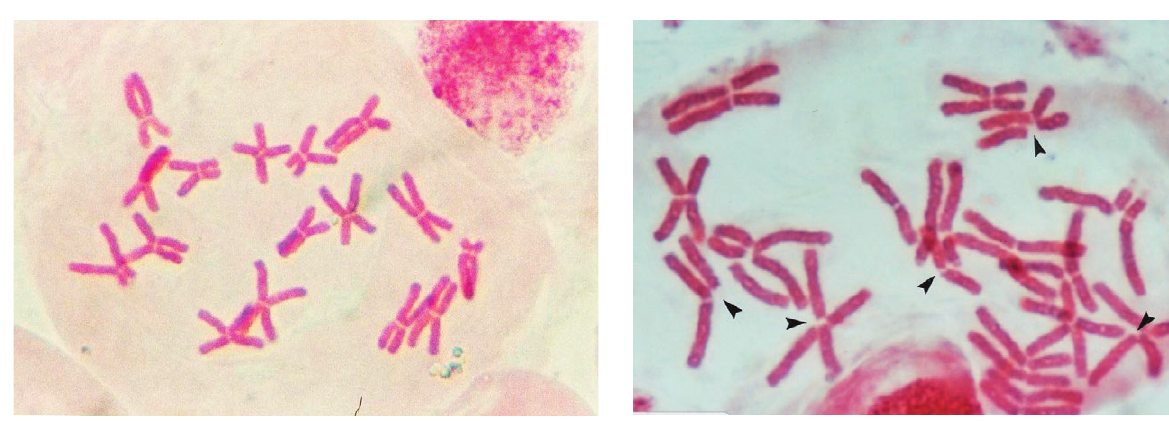
Figure 3. Diploid monocentric metaphase chromosome from the root meristem cells of the onion ( Allium cepa L.), containing 2n of 16, with basic chromosome number x=8 (2n=16).